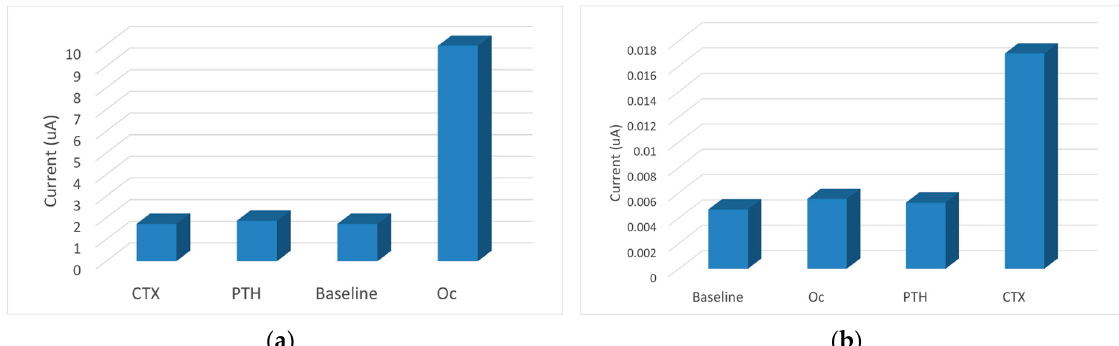
Figure 2. ( a ) Electrochemical response measured for the Oc sensor incubated with CTX (100 ng/mL), PTH (100 ng/mL), and Oc (100 ng/mL); and ( b ) the response measured for CTX sensor incubated with the Oc (100 pg/mL), PTH (100 pg/mL), and CTX (100 pg/mL).